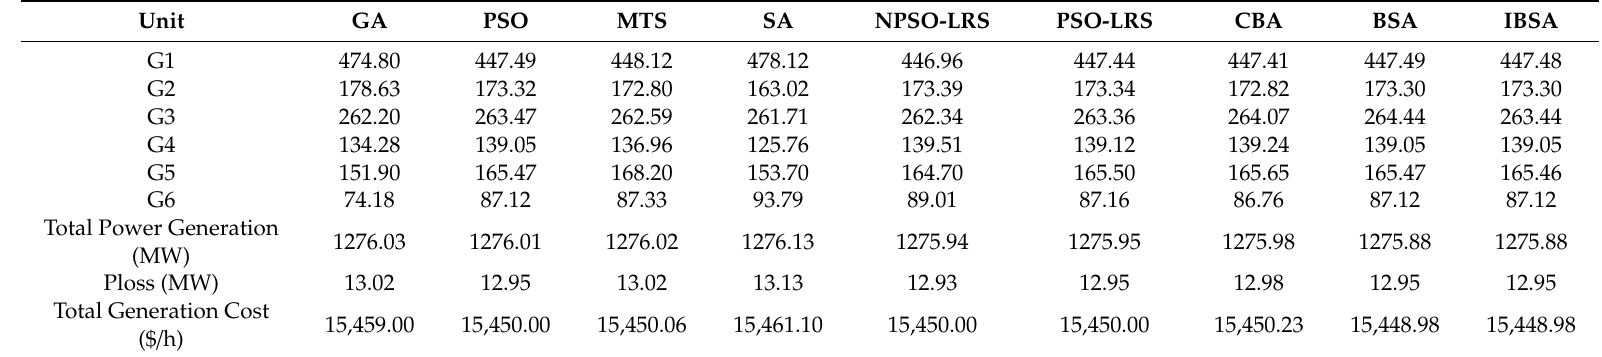
Table 5. Dispatch results of System